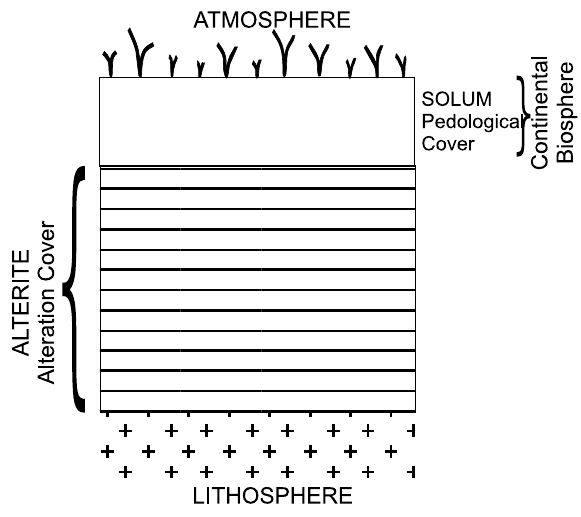
Fig. 1 – Alteration cover (alterite + soil) in relation to atmosphere and continental biosphere (Pedro 1985).